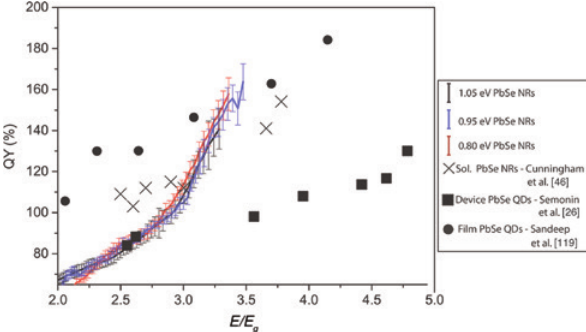
Figure 5: Internal quantum efficiencies (IQEs) of devices based upon PbSe nanorods of three different band gaps (coloured solid lines) and peak quantum yields of devices consisting of spherical PbSe QD (squares). The MEG quantum yields of PbSe nanorods in solution and of spherical PbSe QDs in solid state are shown as crosses and circles, respectively. The figure combines data from [26, 27, 46,